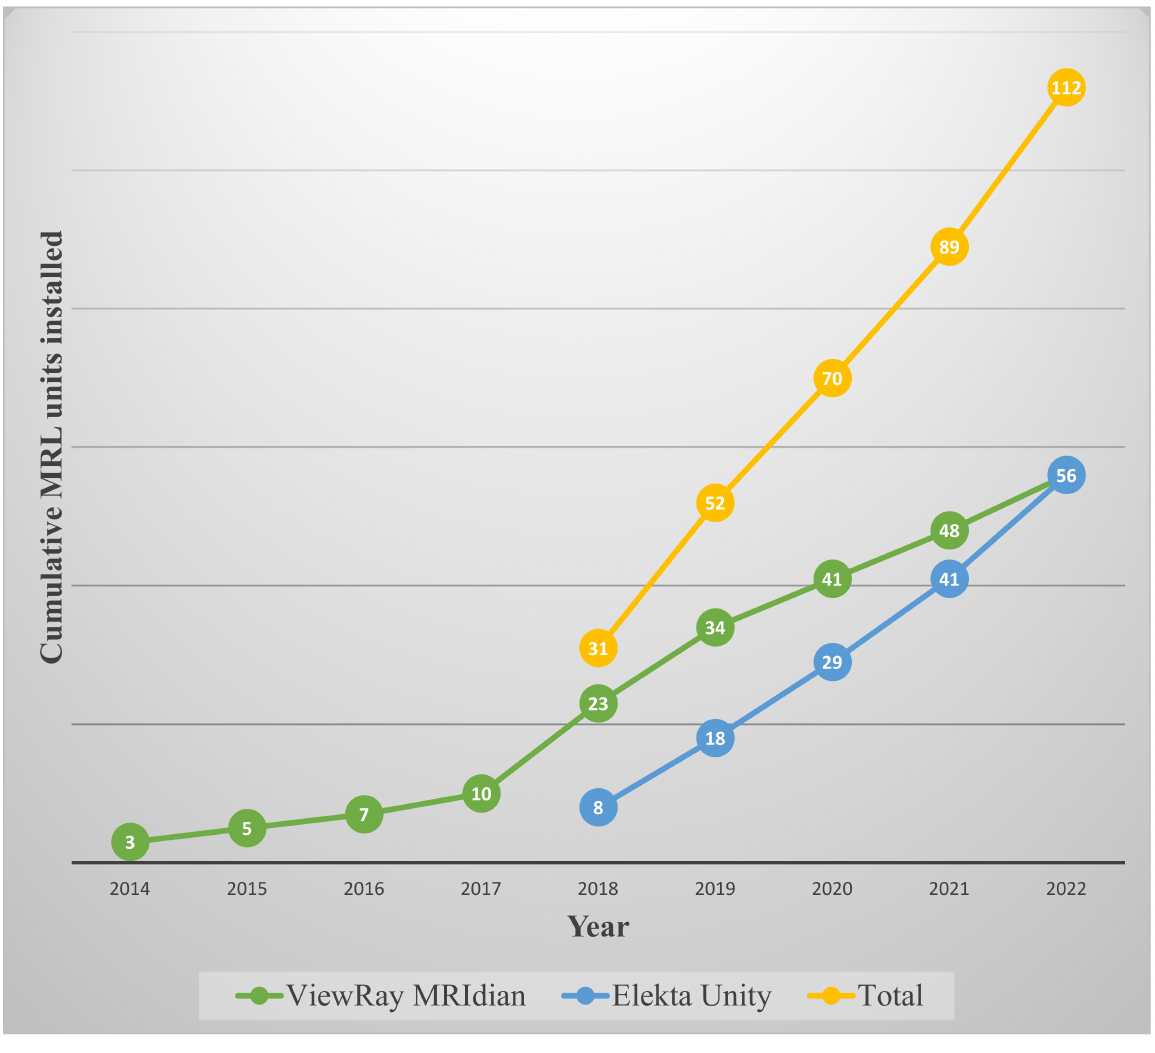
Figure 2. Cumulative installations of ViewRay MRIdian and Elekta Unity MRLs over time. ViewRay MRIdian was initially a tri- 60 Co system, with MRL installations beginning in 2017. All existing ViewRay MRIdian systems, except for one, have been upgraded to MRLs. Elekta Unity systems were initially pre-clinical until late 2019. All existing Elekta Unity systems have been upgraded to fully clinical systems. Data used for the creation of Figure 2 were directly provided by Elekta and ViewRay team